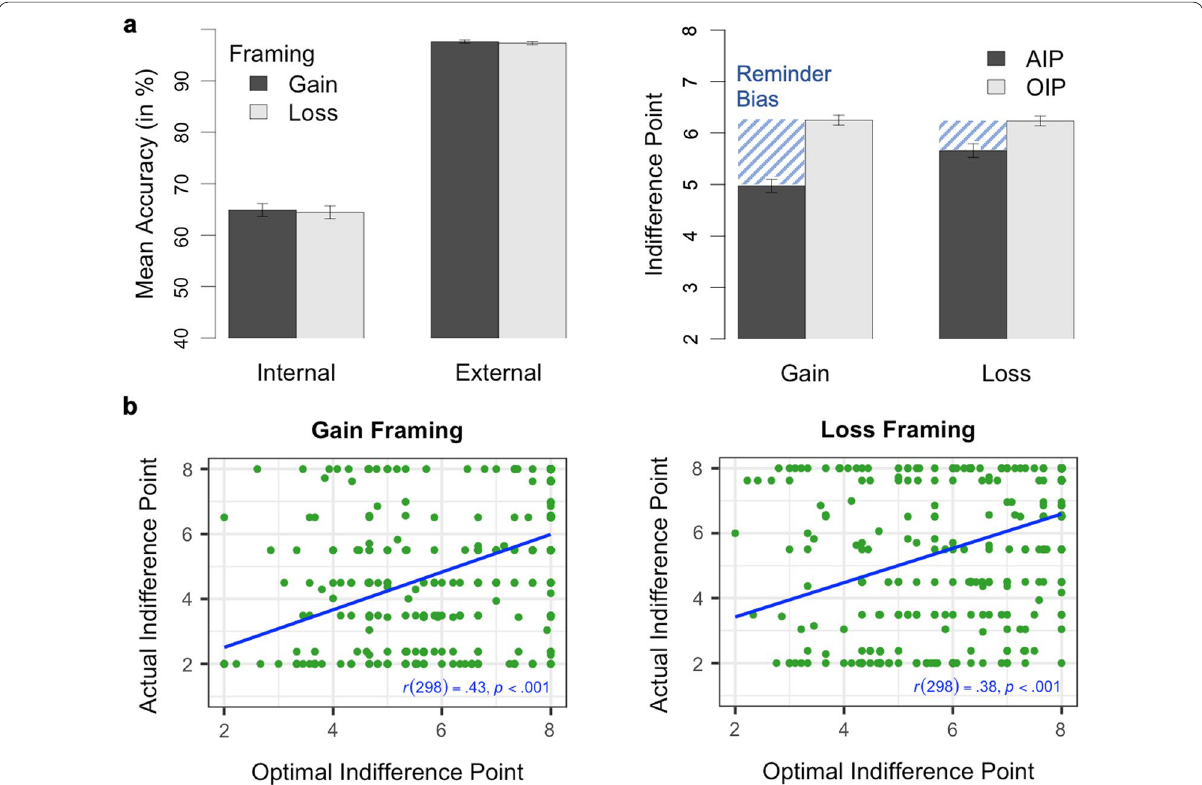
Fig. 5 Results on Offloading Behavior from Experiment 2. Note a In the left panel, mean accuracy for the forced‑internal and forced‑external trials in the gain and loss framing condition. Mean optimal (OIPs) and actual indifference points (AIPs) as a function of framing condition in the right panel. The line pattern demonstrates the size of the reminder bias defined as OIP minus AIP. b Correlation between actual and optimal indifference points for the gain and loss framing condition. a Error bars represent standard